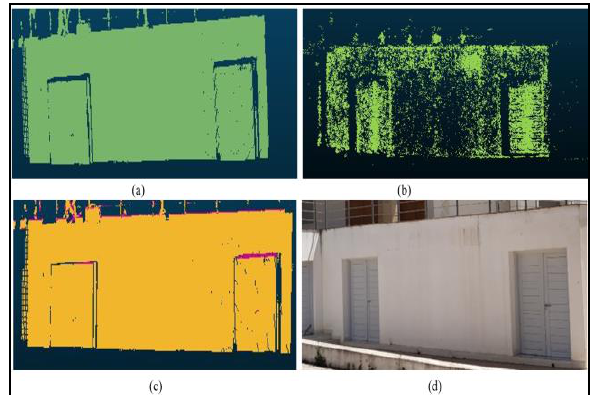
Figure 6 . Extraction of doors from different point clouds: (a) from TLS, (b) from Drone, (c) from merged point cloud, (d)